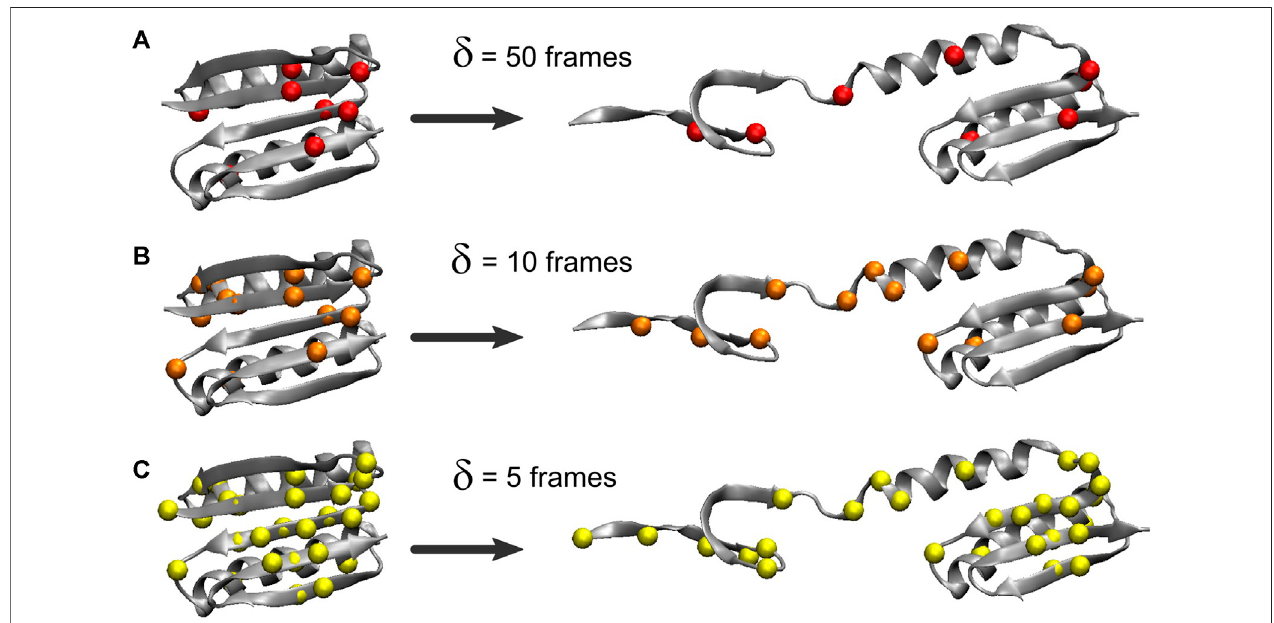
FIGURE 3 | Residues highlighted by the MI analysis of the constant velocity unfolding trajectory. The shown residues were taken from the residue pairs extracted fromtheactivitymatrixwhenthecorrespondingnormalizedmatrixelementsweregreaterthan0.7.TheresiduesaredepictedbytheirC α atomsandcorrespondtomatrix elementsin Figure 2 (right). The visualization isbased on the analysiswith the RMSF smoothing windows of δ (cid:1) 50 (A) , 10 (B) , and 5 (C) frames used in Figure 2 δ (cid:1) 50 emphasizes residues 9, 12, 26, 36, 47, 48, 62, and 91, δ (cid:1) 10 emphasizes residues 6, 9, 12, 23, 26, 28, 29, 36, 47, 48, 55, 62, and 91, and δ (cid:1) 5 emphasizes residues 3, 6, 9, 11, 12, 14, 23, 26, 28, 29, 36, 45 – 52, 55, 62, 72, 80, 81, and 89 –